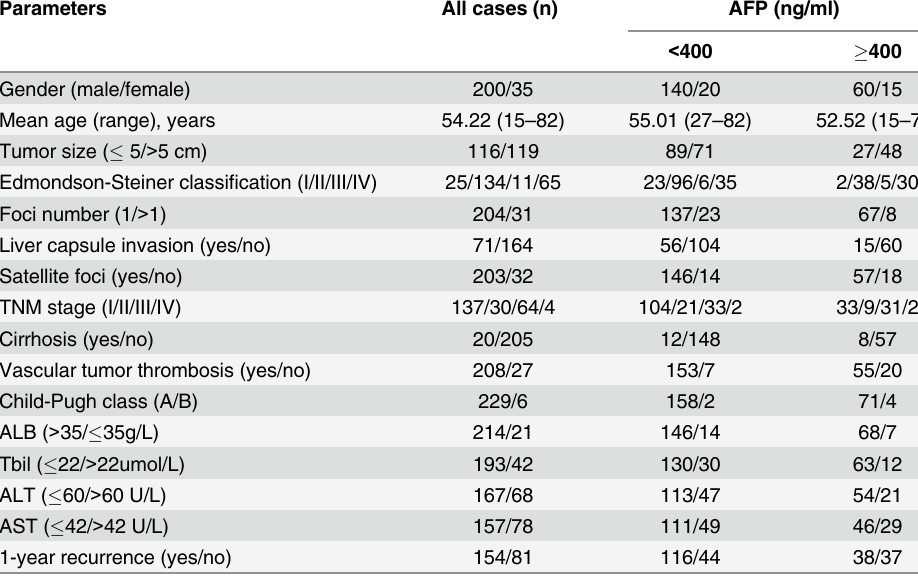
Table 1. Demographic and clinical parameters of patients with HBV-related HCC undergoing radical resection.